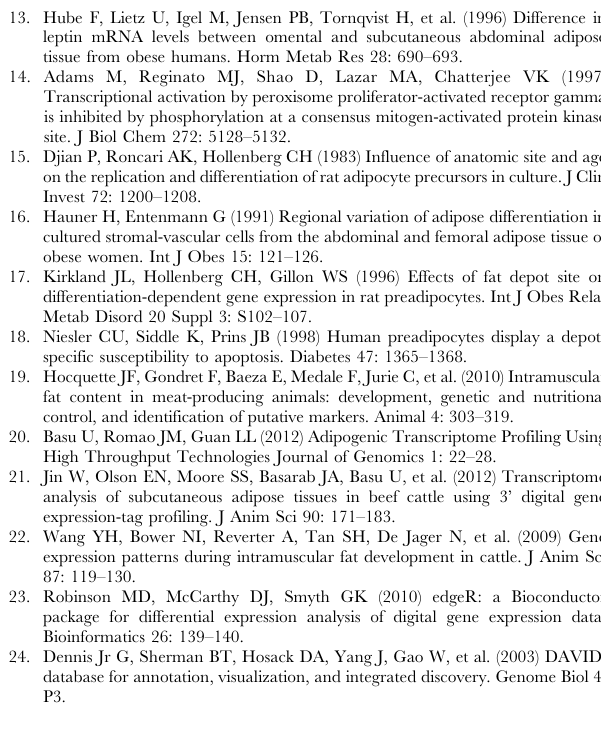
Table S4 Statistical analysis of the correlation between RNAseq and qRT-PCR. Table S5 Biological process GO terms of DEGs resulted from pairwise comparison among three different adi- pose depots. Table S6 GO terms of cellular components and molec- ular function of depot specific DEGs. Table S7 KEGG pathways of DEGs resulted from the pairwise comparison among three different adipose depots. Table S8 Summary of the enriched KEGG pathway results based on the depot specific